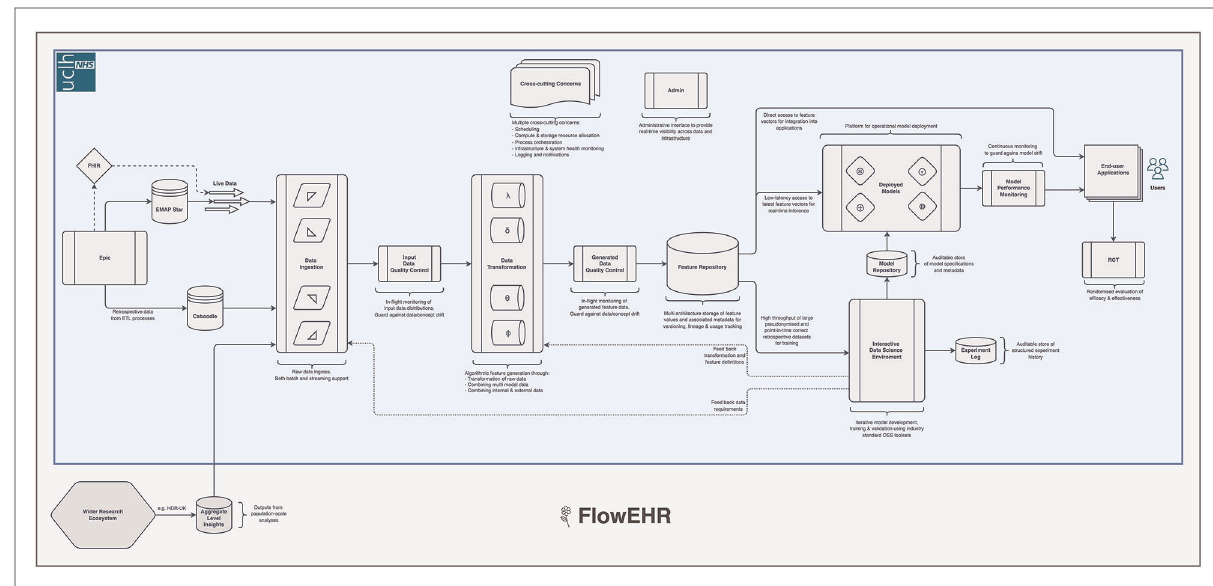
FIGURE 2 Our ML-Ops platform is called FlowEHR. Moving from left to right across the fi gure, the system monitors raw input data including checks for distribution shift, builds features with testable and quality controlled code, makes those features available to for both training and predictions to avoid train/serve skew, and maintains an auditable and monitored model